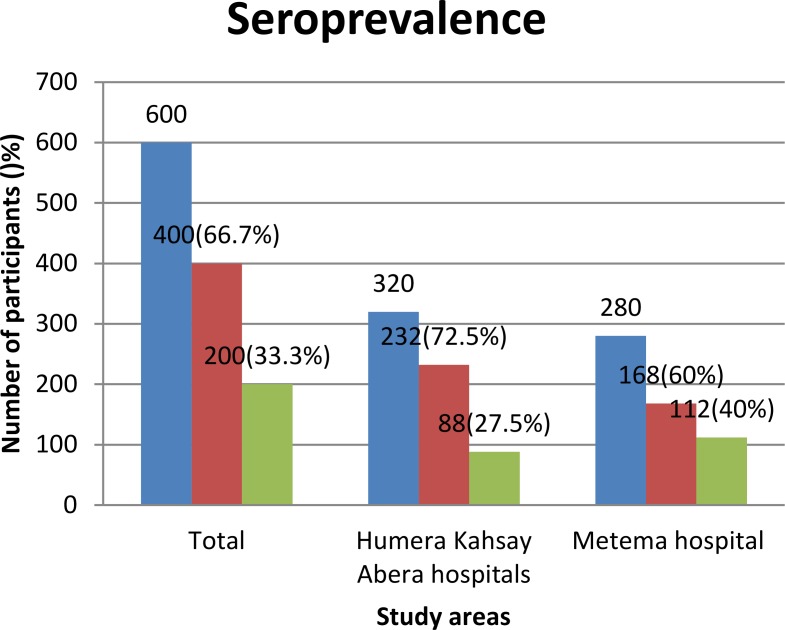
Seroprevalence of DENV infection, from March 2016 to May 2017.Blue: total number of study participants; red: study participants negative against anti-DENV antibodies; green: study participants positive against anti-DENV antibodies.